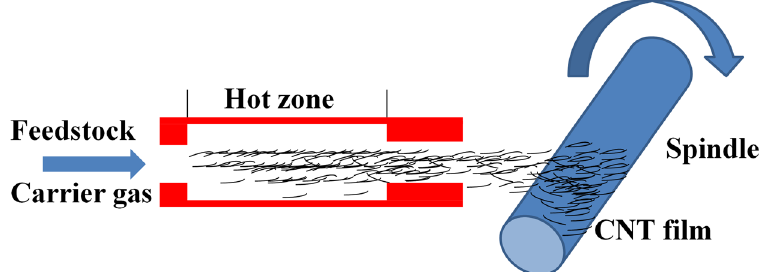
Figure 8. Schematics of CNT film